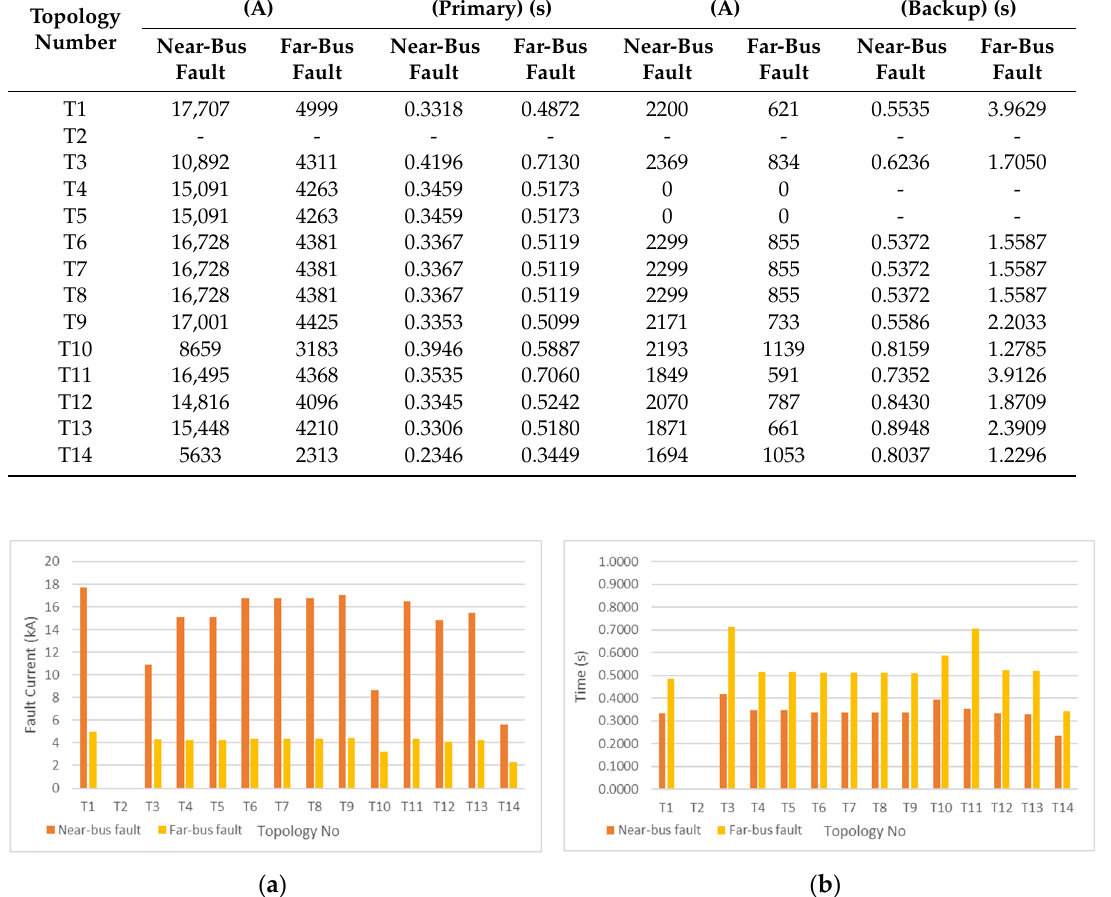
Table 17. Fault current and operating time for different topologies in primary/backup pair R4 and R7. Topology